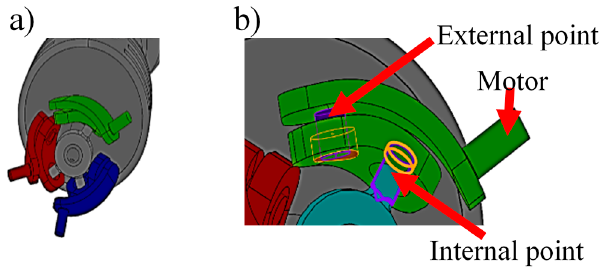
Figure 12. Spheric manipulator. ( a ) Links marked with colors. ( b ) Points of interest for each pair of links. Table 7. Reaction forces of the ball gripping mechanism.